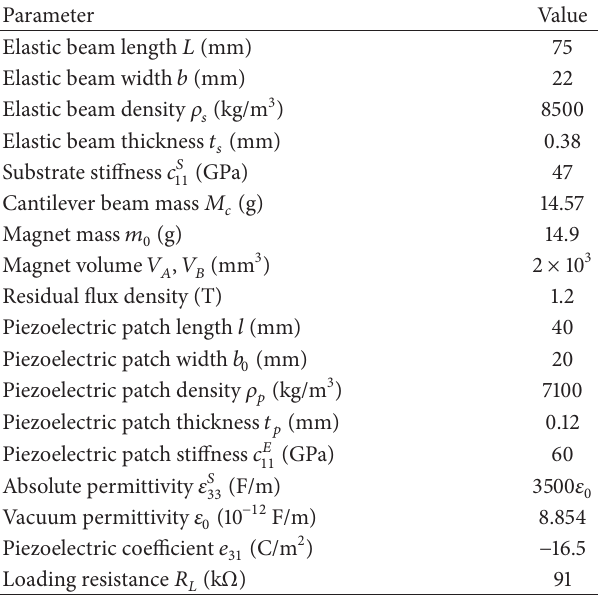
Table 1: Geometric and material properties of the bistable piezo- electric cantilever generator.